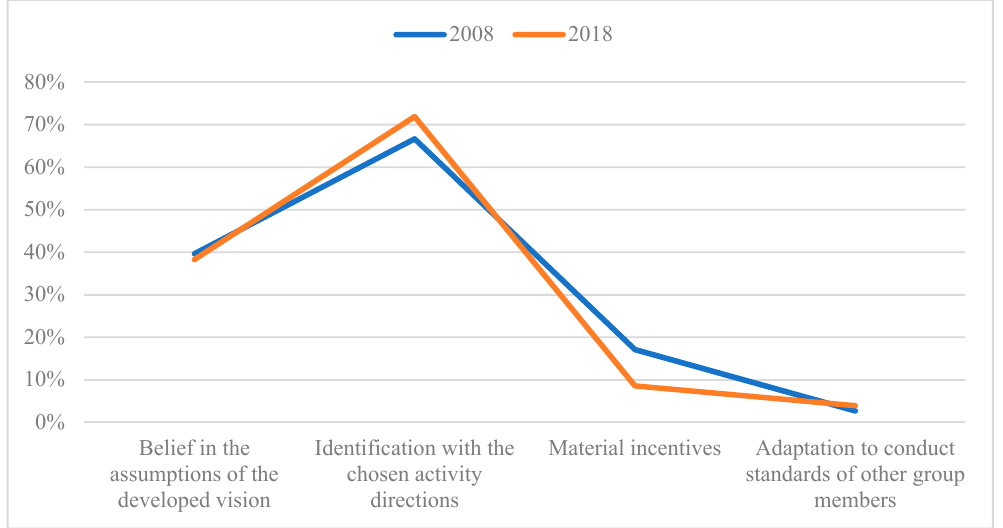
Figure 5. Motives driving subordinates to follow the developed vision as assessed by leaders of the Forbes Global 2000 world’s largest corporations.